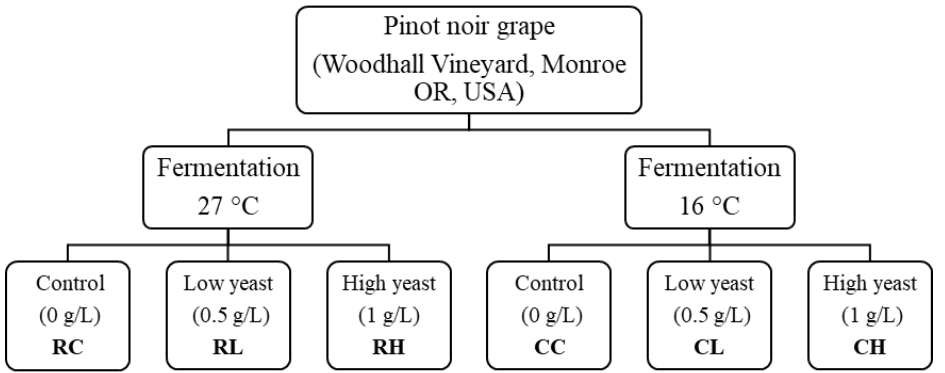
Figure 1. Pinot noir wine treatments scheme. (RC = fermentation at 27 ◦ C, 0 g/L yeast product addi- tion; RL = fermentation at 27 ◦ C, 0.5 g/L yeast product addition; RH = fermentation at 27 ◦ C, 1 g/L yeast product addition; CC = fermentation at 16 ◦ C, 0 g/L yeast product addition; CL = fermentation at 16 ◦ C, 0.5 g/L yeast product addition; CH = fermentation at 16 ◦ C, 1 g/L yeast product addition).